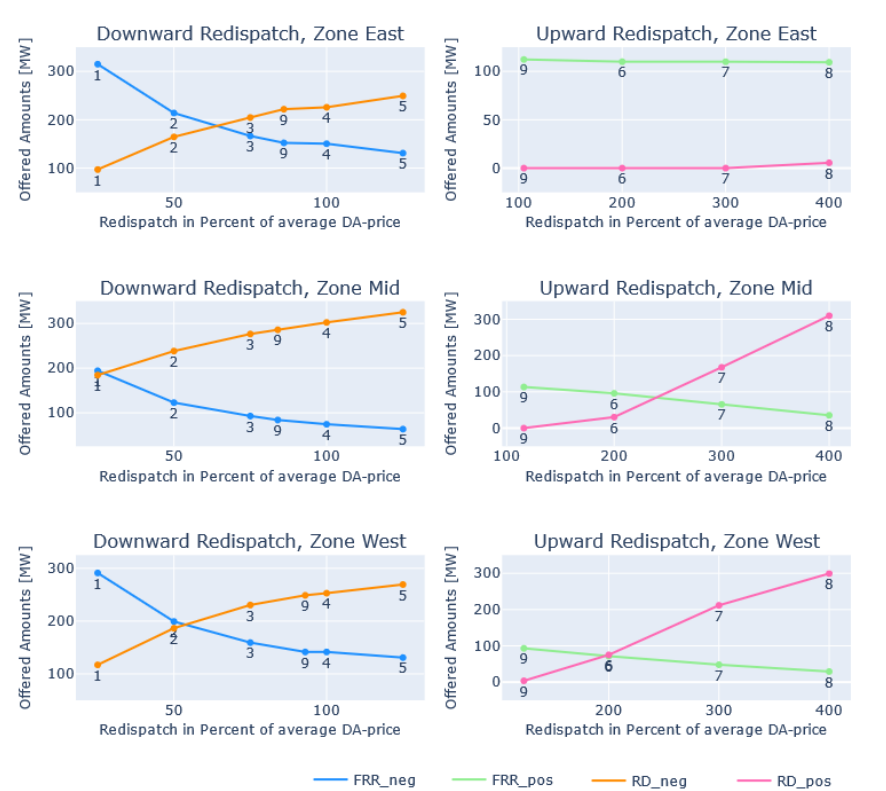
Figure 4. Amounts of energy that have been bid by the VPP on the downward balancing and redispatch markets ( left column ) or upward balancing and redispatch markets ( right column ) in the three zones of Austria, from July to December